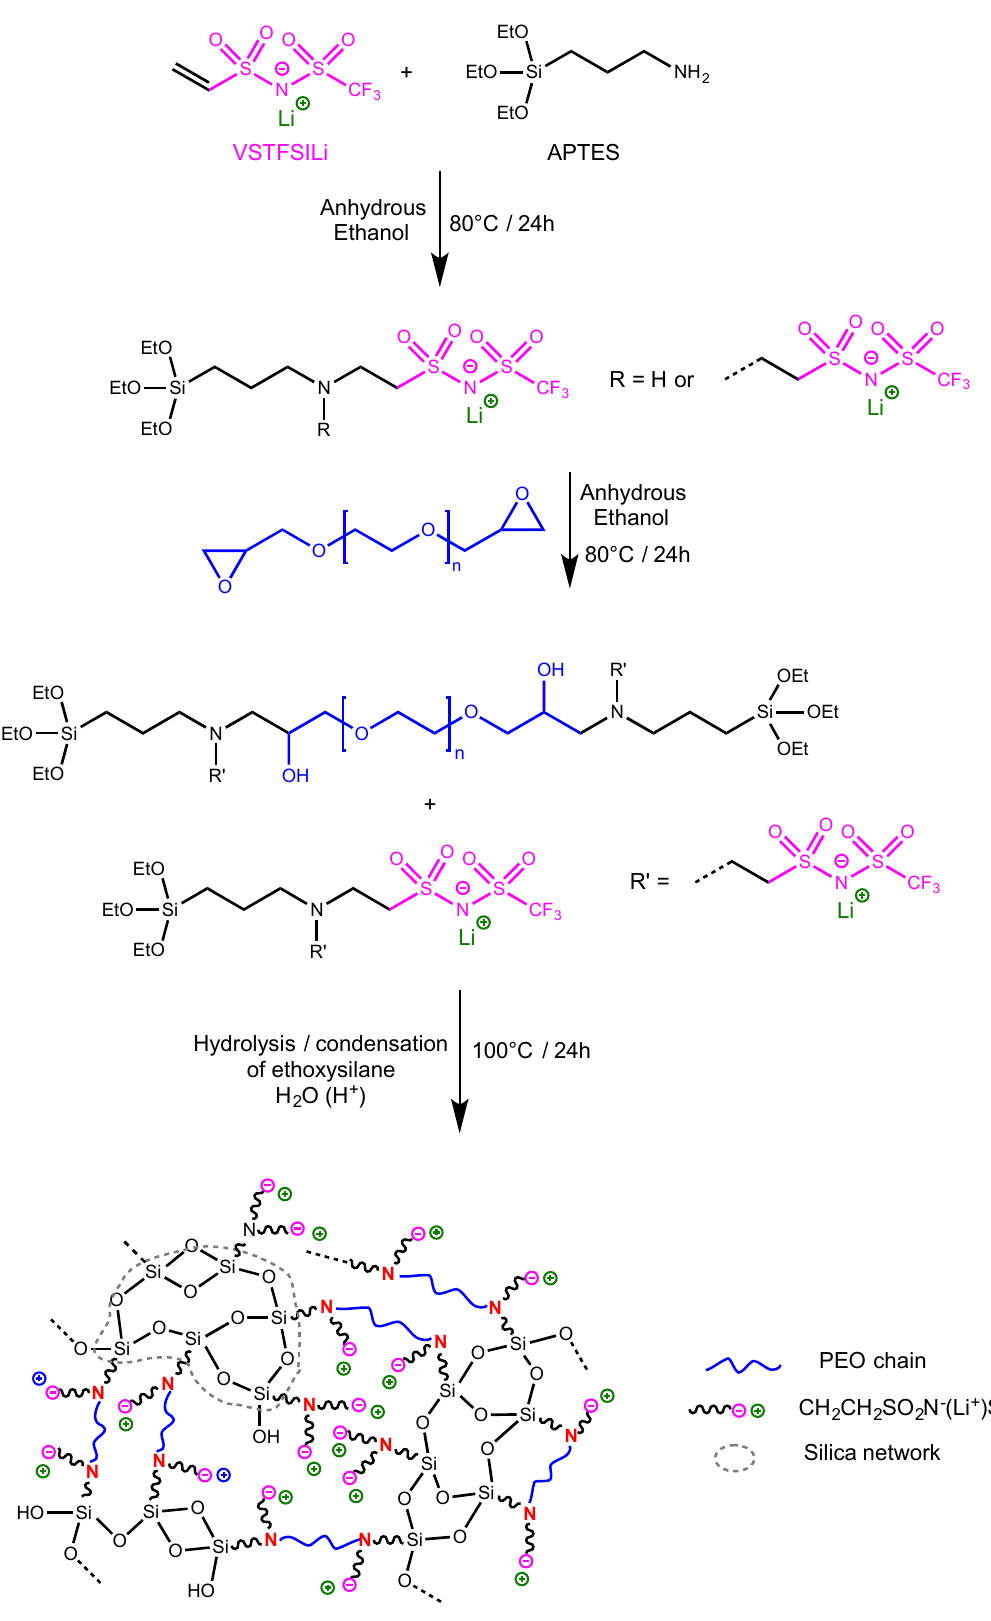
Figure 1. Synthesis route of hybrid single-ion electrolytes.